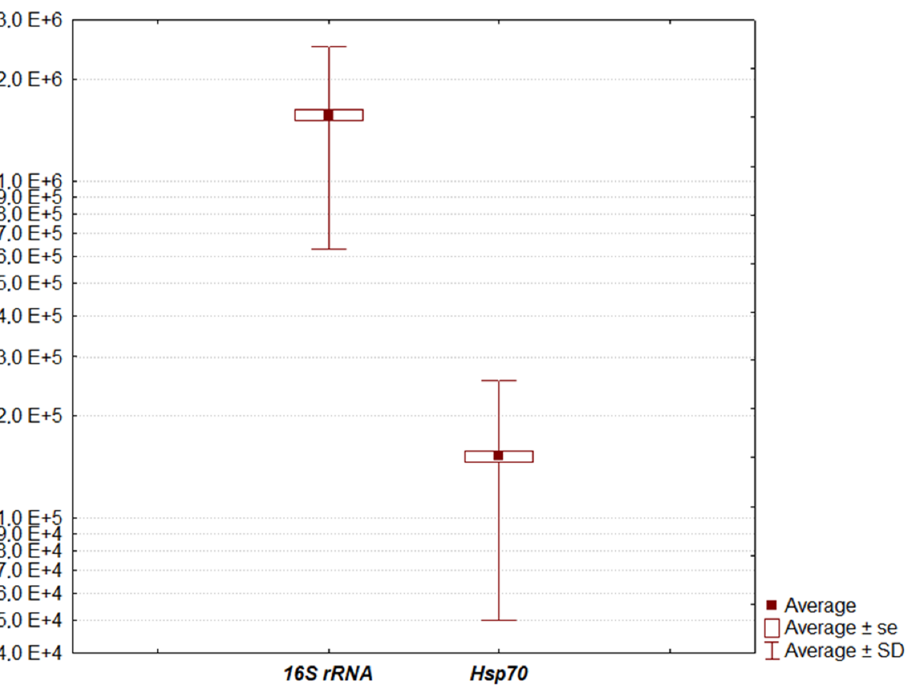
Figure 1. Boxplot showing average, standard error and standard deviation of the individual N. ceranae abundance values measured with the two methods examined here ( 16S rRNA and Hsp70 ). The number of copies is reported against a logarithmic vertical axis.